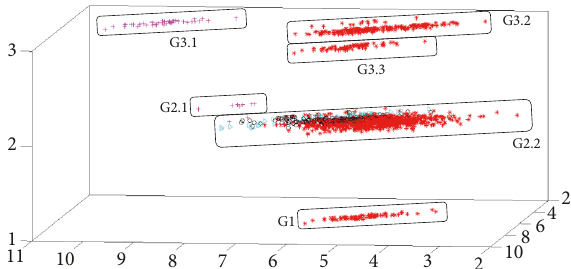
Figure 4: HUEP: CMLHL + partitional clustering ( k =3) + Psychic - Democracy